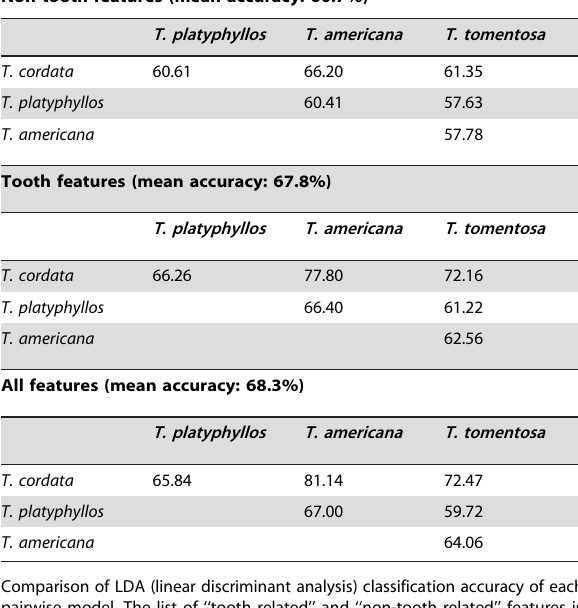
Table 5. Species identification using pairwise LDA.